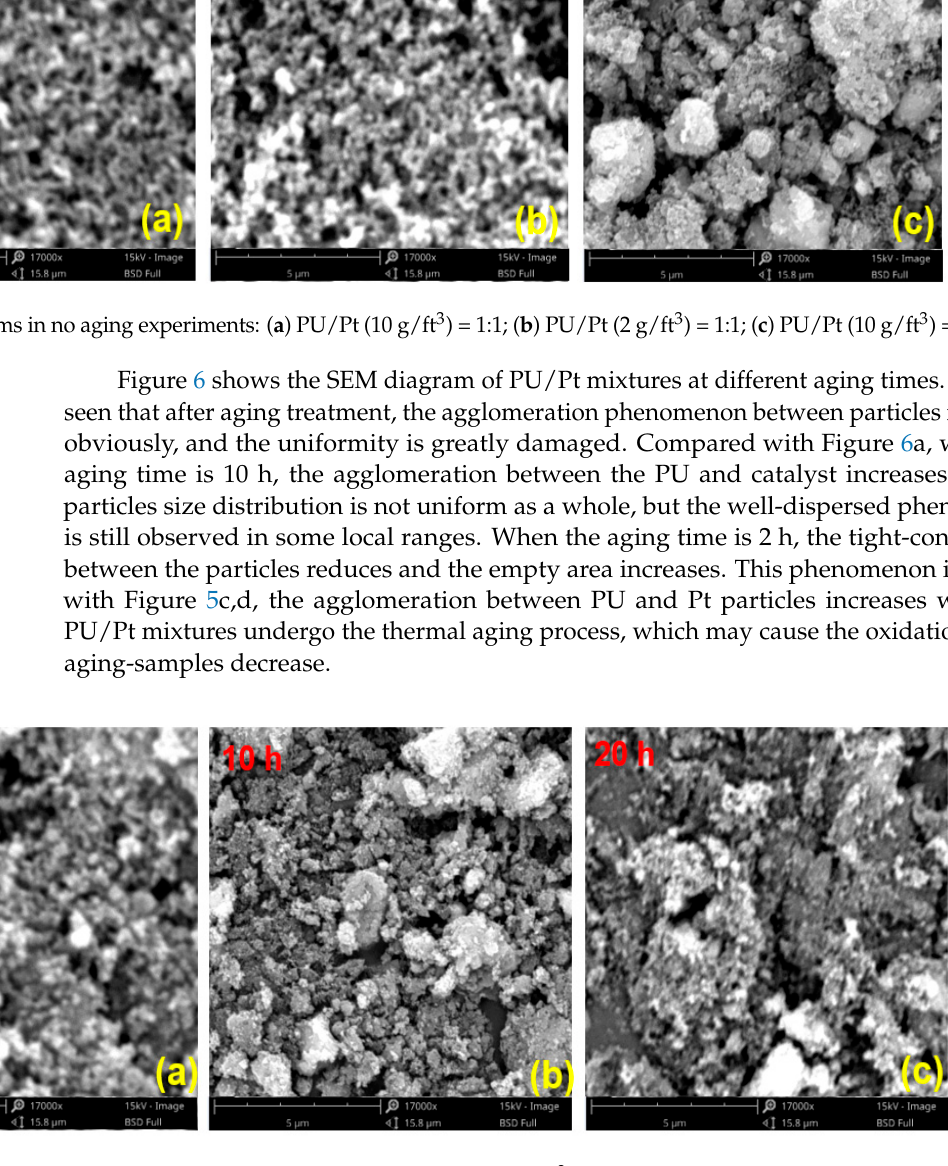
Figure 6. SEM diagrams in different aging times at 350 °C with PU/Pt (10 g/ft 3 ) mixtures at 1:1 mass ratio: ( a ) 2 h; ( b ) 10 h; ( c ) 20 h.